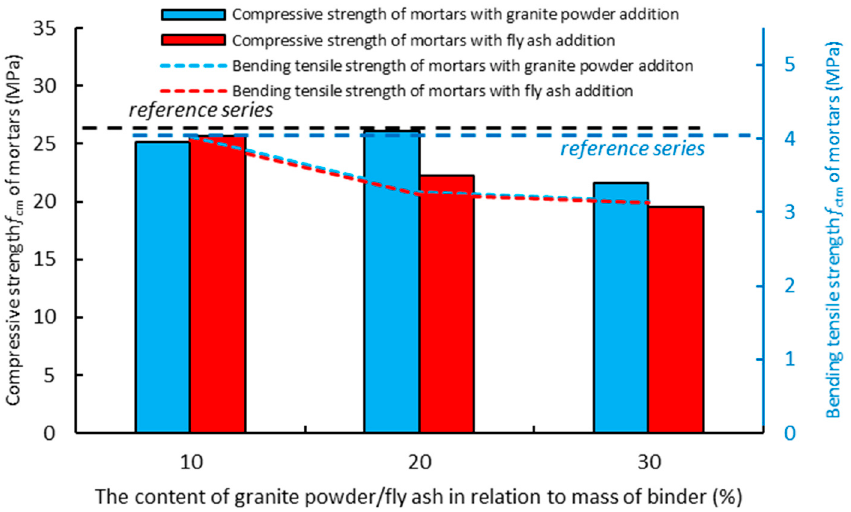
Figure 10. The effect of replacing the cement with the granite powder or fly ash on the compressive strength ( f cm ) and bending tensile strength ( f ctm ) of the air-cured hardened cementitious composites after seven days.